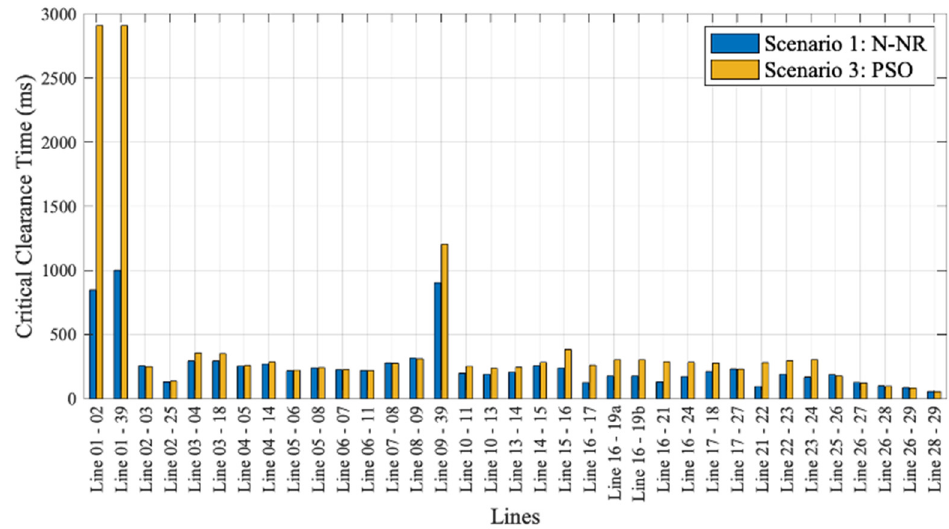
Figure 9. Scenarios 1 and 3 CCT for faults in every line of the network.